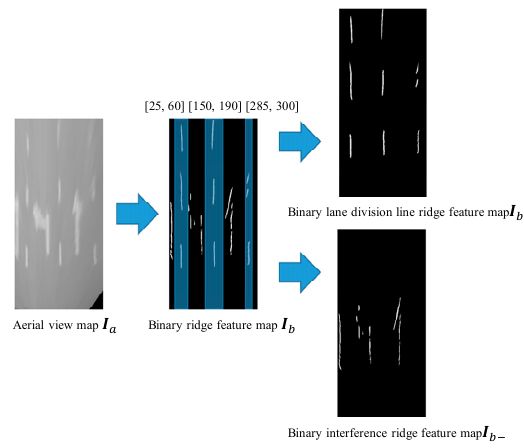
Figure 6. Pictorial example for dividing binary ridge map I b .